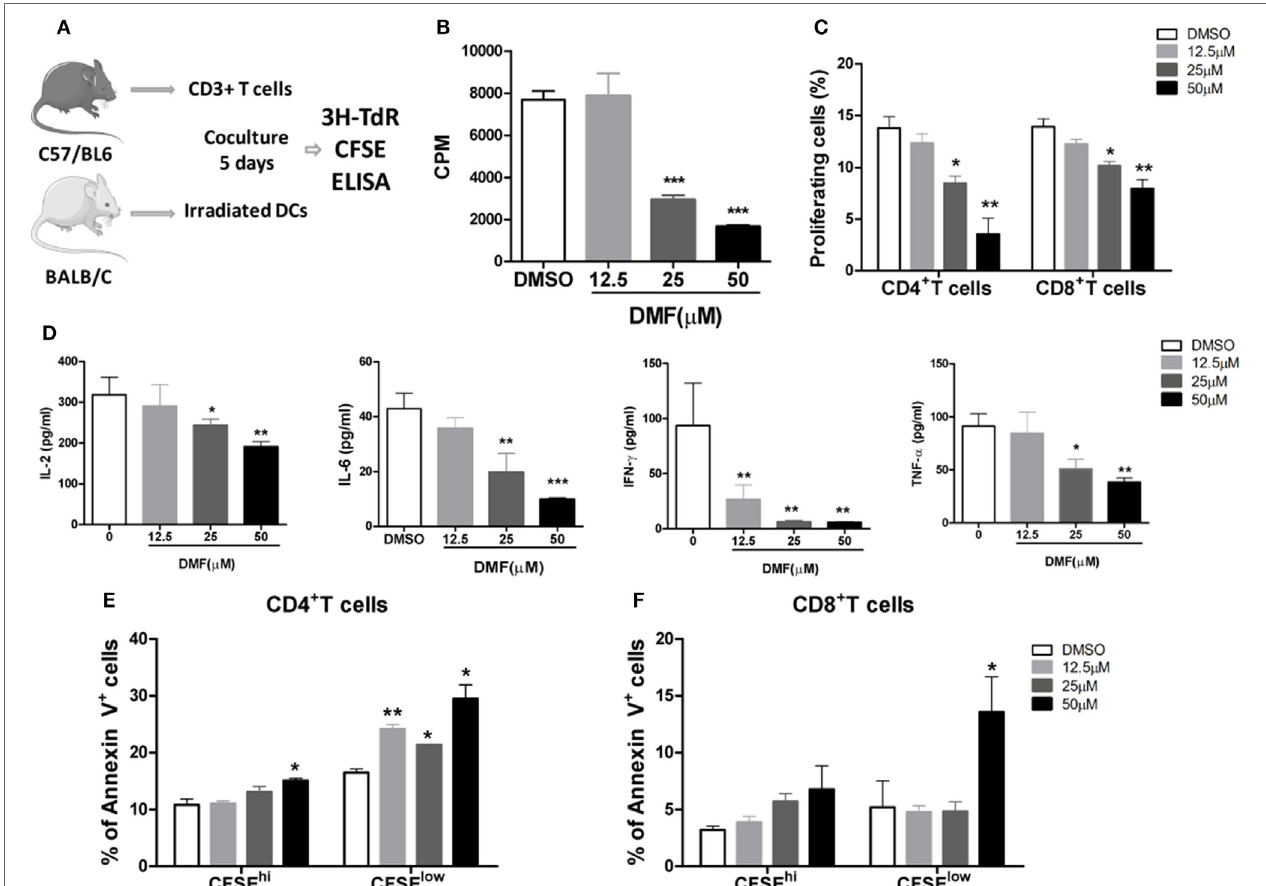
FigUre 1 | Dimethyl fumarate (DMF) inhibits alloreactive T cell responses in vitro . BMDCs from BALB/c mice were cocultured with allogeneic splenic CD3 + T cells purified from C57BL/6 mice, in the presence of the DMF (a) , 5 days later, cell proliferation was evaluated by 3 H-TdR (B) or CFSE (c) . The levels of proinflammatory cytokines IL-2, IL-6, IFN- γ , and TNF- α in the supernatants were examined by ELISA (D) . Cell apoptosis of alloreactive CD4 + T cells and CD8 + T cells was examined by Annexin V staining (e,F) . Data shown are mean ± SD. * P < 0.05; ** P < 0.01; *** P < 0.001, compared with DMSO group (ANOVA with Dunnett’s